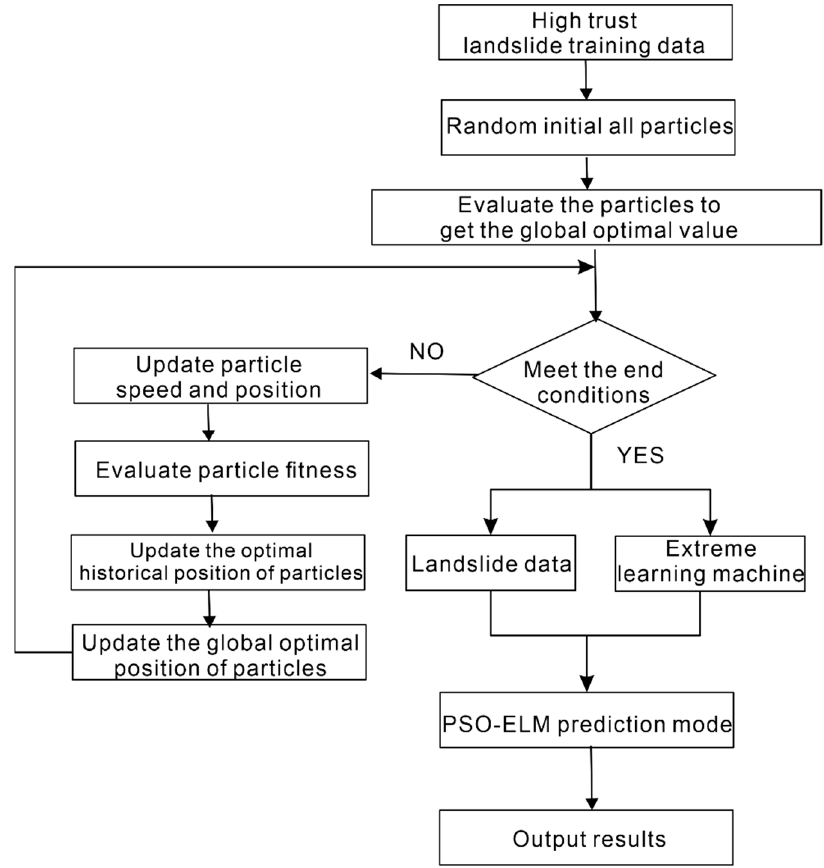
Figure 9. PSO-ELM flowchart.